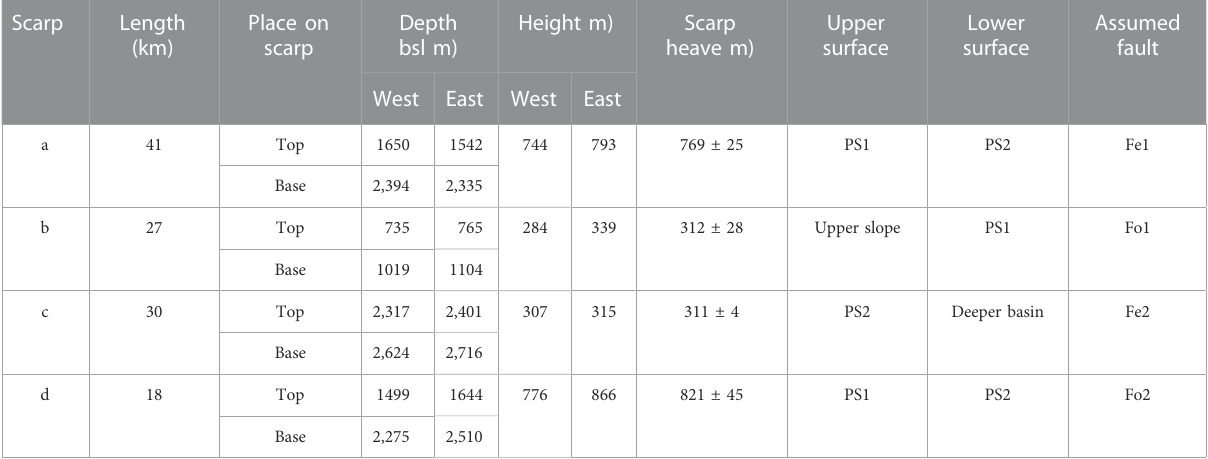
TABLE2Characteristicsofthemaincumulativescarpsidenti fi edoffBoumerdès.Scarps,perchedsurfacesandheavesareidenti fi edonFigure10.Heavevalues represent only the vertical components.